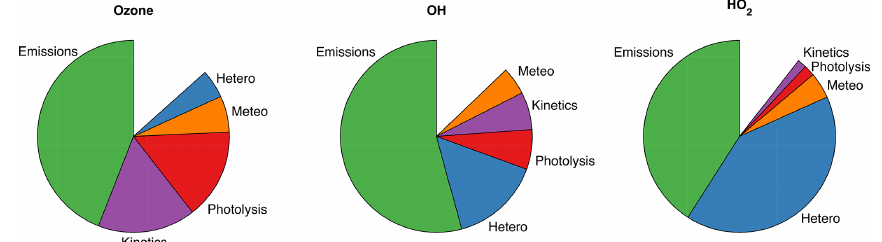
Figure 8. First-order sensitivity indices for modeled O 3 , OH, and HO 2 during ARCTAS-B averaged across all flights and binned by categories defined in Table 1.